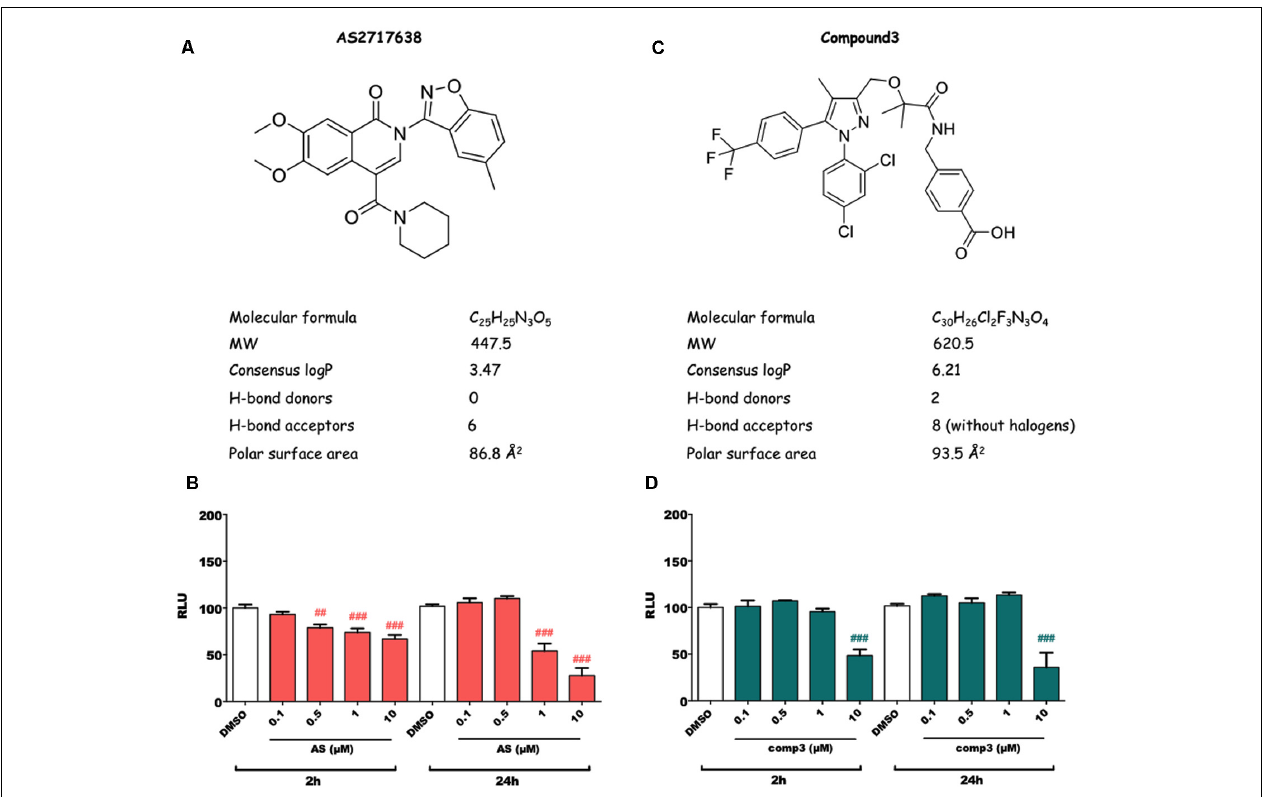
FIGURE 1 | Structure, physicochemical properties and cytotoxic potential of AS2717638 and compound 3. Chemical structures of AS2717638 (A) and compound 3 (C) . SwissADME was used to calculate physicochemical properties relevant to the “ rule of five ” that predict drug-likeliness of a compound (Lipinski et al., 2001). Cytotoxicity was assessed using the MTT assay. BV-2 microglia cells were cultured in 6-well plates, serum-starved overnight (o/n) and incubated with the indicated concentrations of AS2717638 (B) and compound 3 (D) in DMSO for 2 and 24 h. DMSO was used as vehicle control. For convenience, the names of the inhibitors are presented as AS and comp3. Results from three independent experiments in triplicates are presented as mean ± SD ( ## p < 0.01, ### p < 0.001 compared to vehicle control; one-way ANOVA with Bonferroni